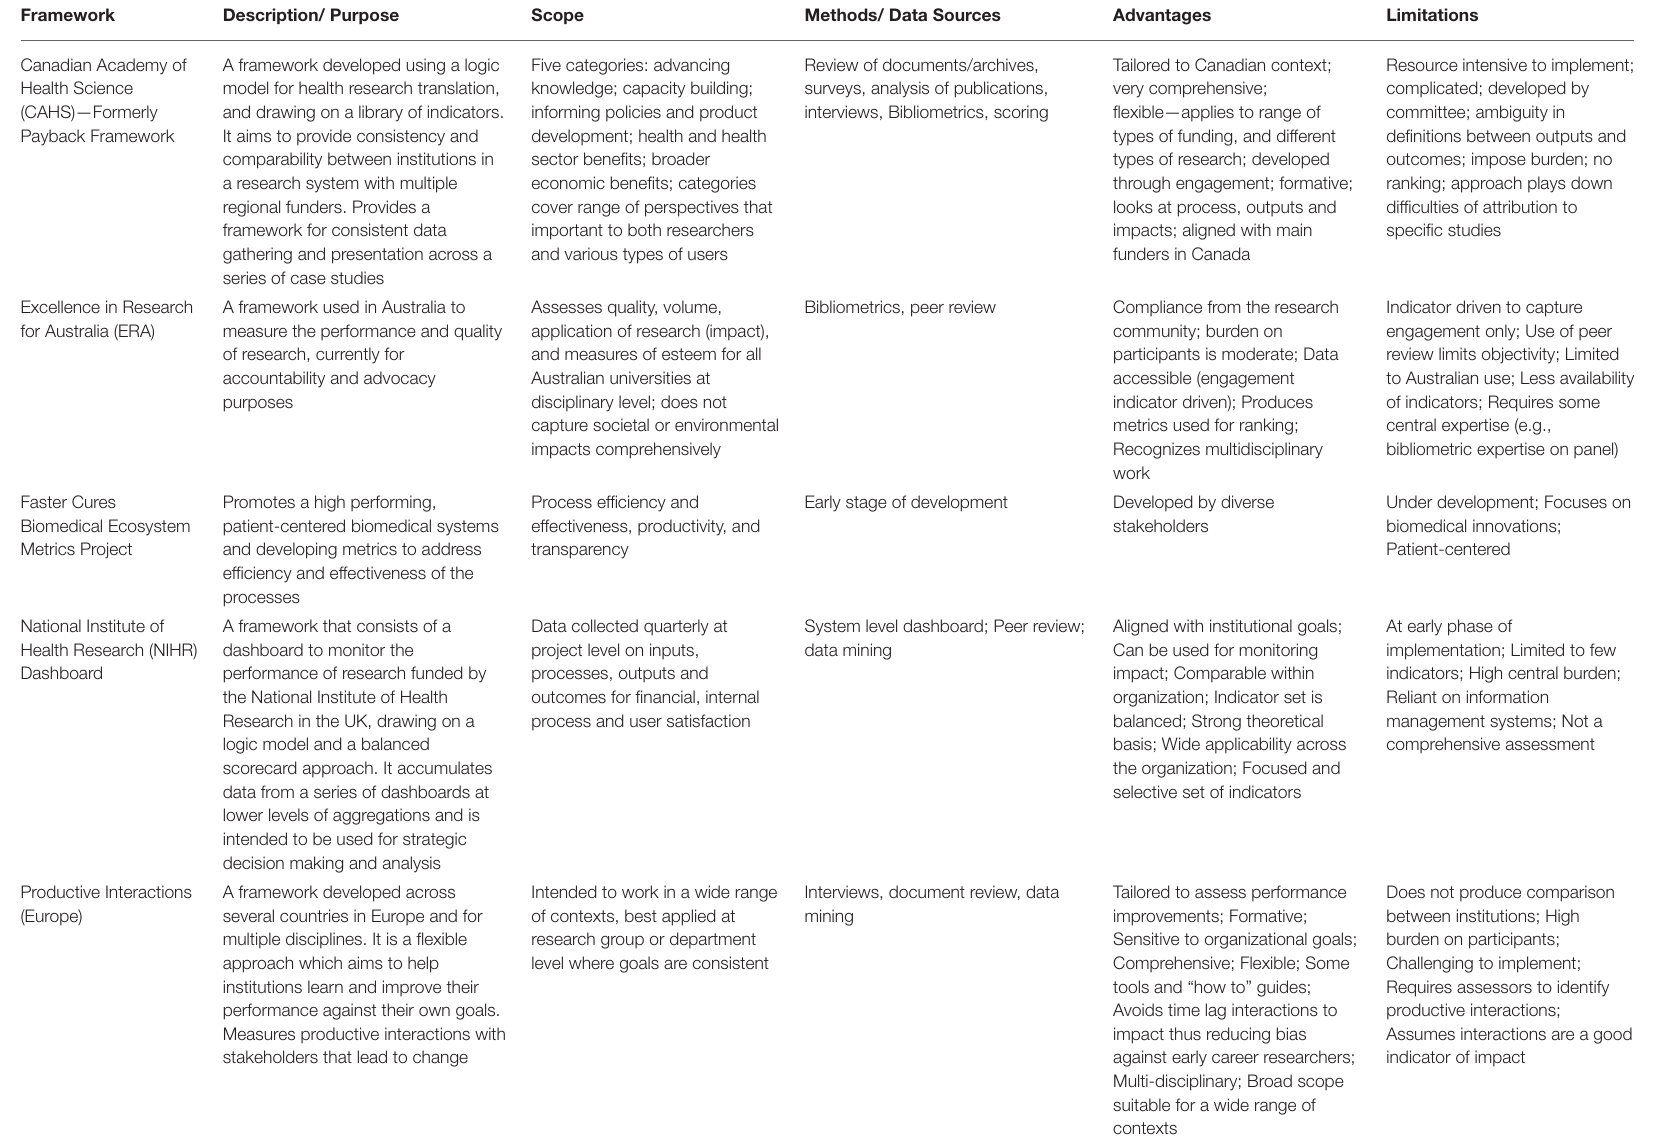
TABLE 1 | Descriptions of selected research assessment